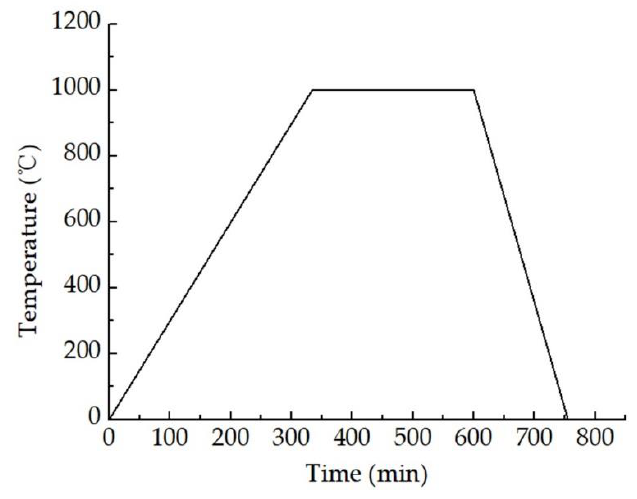
Figure 8. SiAlCO ceramic pyrolysis temperature curve.